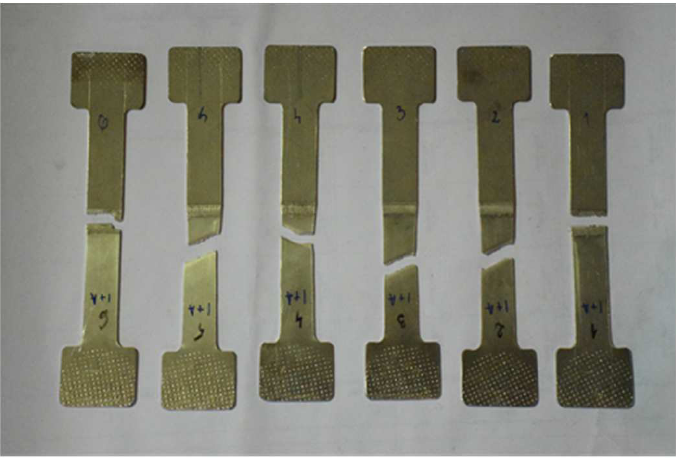
Figure 8. Pictures of the six specimens after the tensile test.